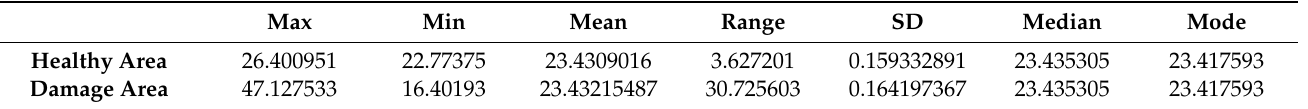
Table 6. Statistical results for the thin samples based on the reflection mode (processed data).